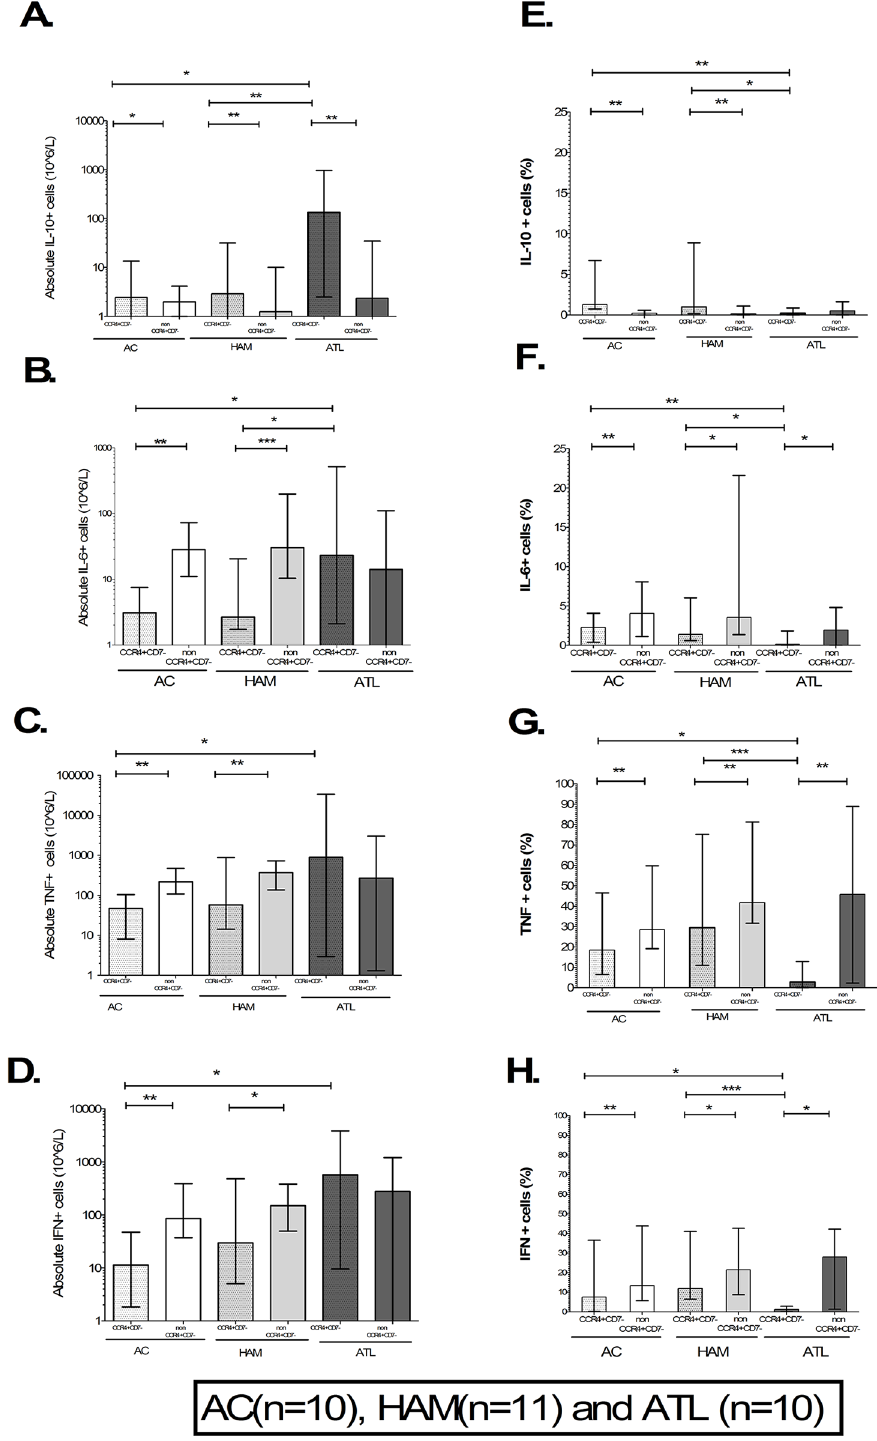
Fig 6. CD4+T-cell subsets cytokine producing profile in non-ATL HTLV-1 infection and ATL. A-H) Bar column plots showing absolute and relative frequency of CCR4+CD7- and non CCR4+CD7- CD4+T-cell subset in asymptomatic carriers (AC), patients with HTLV-1 associated myelopathy (HAM) and adult T-cell leukaemia/ lymphoma (ATL). The bar represents mean values and error bar the standard deviation. Statistical analysis: Kruskal- Wallis test with Dunn post-test, 95% confidence interval and Wilcoxon signed rank test. (cid:3) denotes p < 0.05, (cid:3)(cid:3) denotes p < 0.01, (cid:3)(cid:3)(cid:3) denotes p < 0.001.